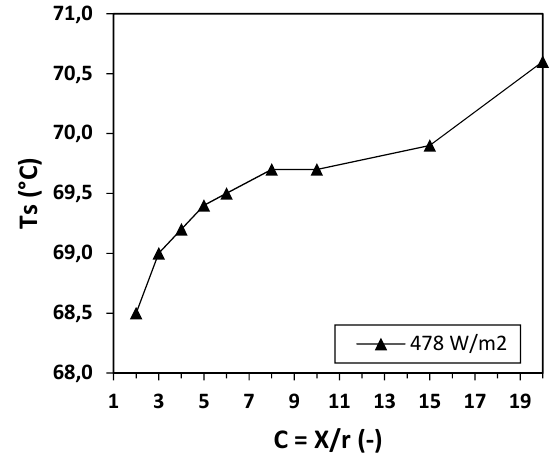
Fig. 6. Surface temperature for q = 478 W/m 2